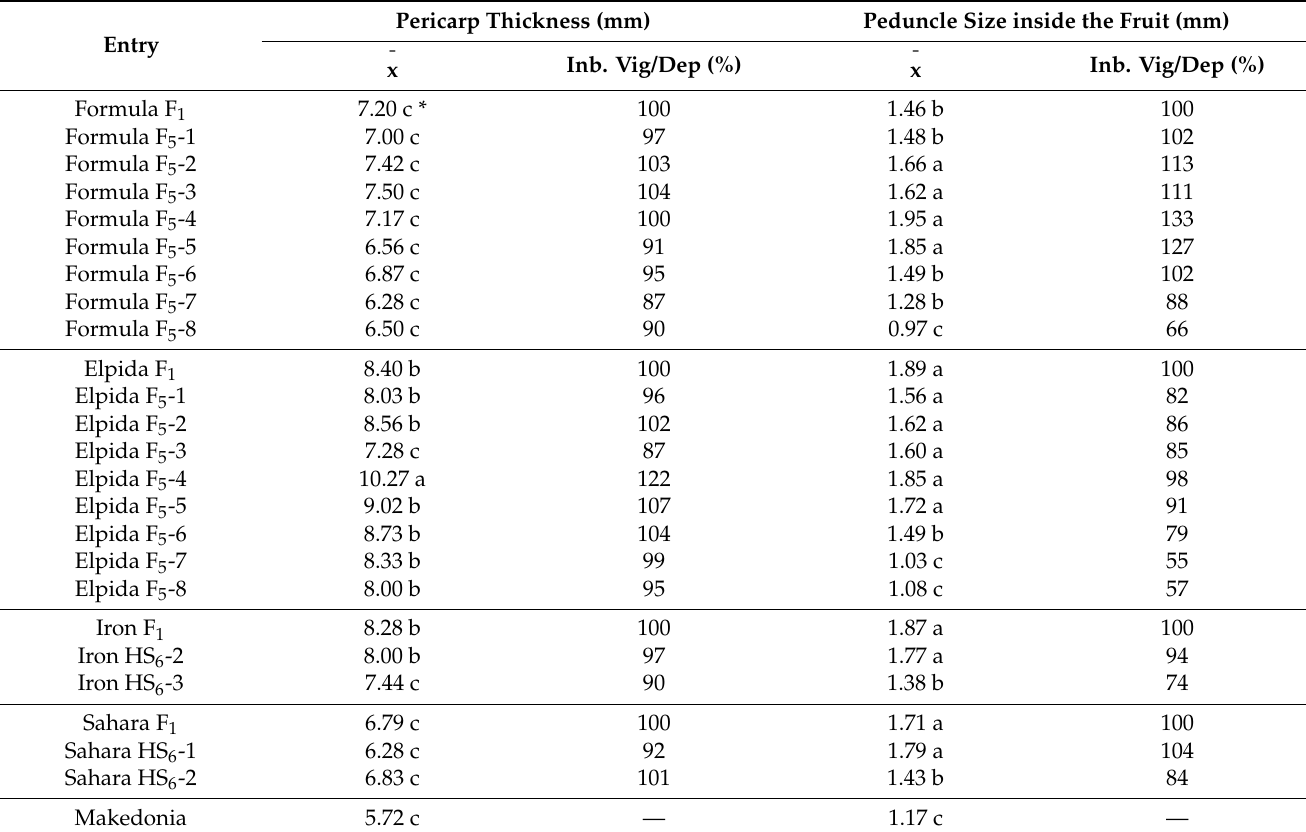
Table 4. Average fruit pericarp thickness, size of peduncle inside the fruit (mm), and inbred vigor/depression (% of corresponding hybrid), for tomato hybrids and recombinant inbred lines.